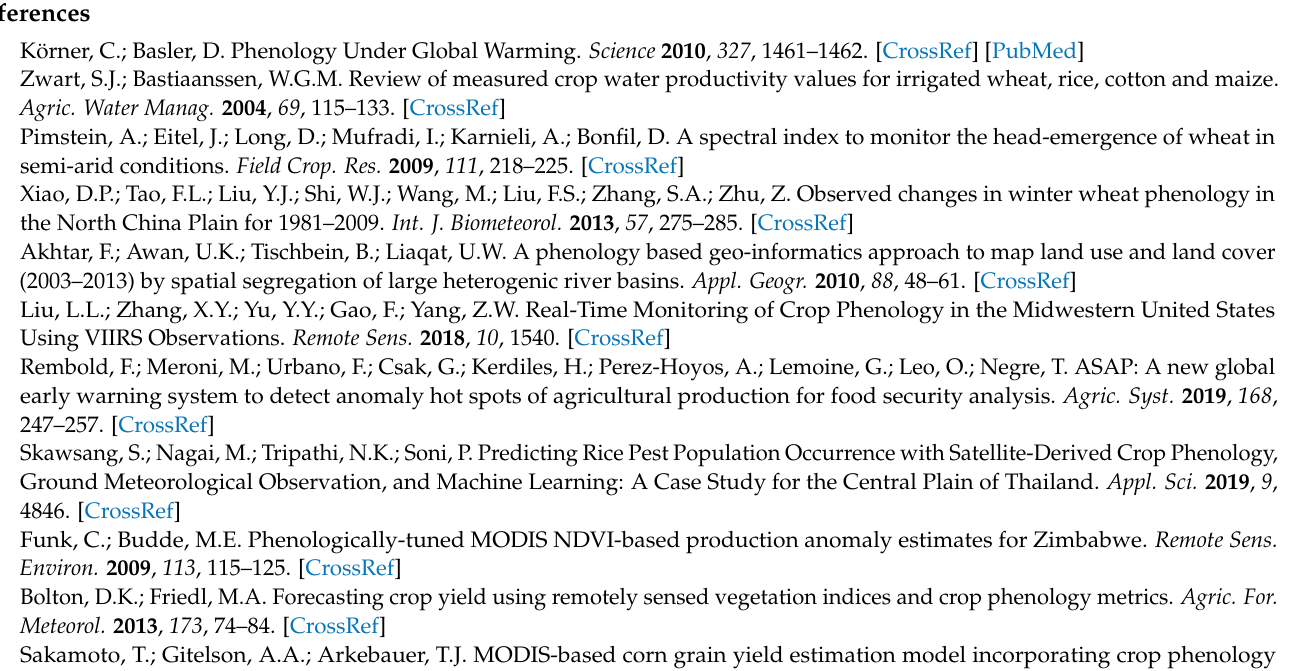
NDVI data for year i; Figure S2: Matching of shape model with growth curve; Figure S3: An example of 24-h temperature fitting; Figure S4: Eight cases to calculate the GDD value. (A,B) refer to the case where the daily maximum temperature is greater than K1 and less than K2. (C–E) refer to the case where the daily maximum temperature is greater than K2 and less than K3. (F–H) refer to the case where the daily maximum temperature is greater than K3; Figure S5: The temperature curves fitted by the sine method and the curve fitting method. (a,b) are temperature curves fitted by the sine method; (c,d) are temperature curves fitted by curve fitting